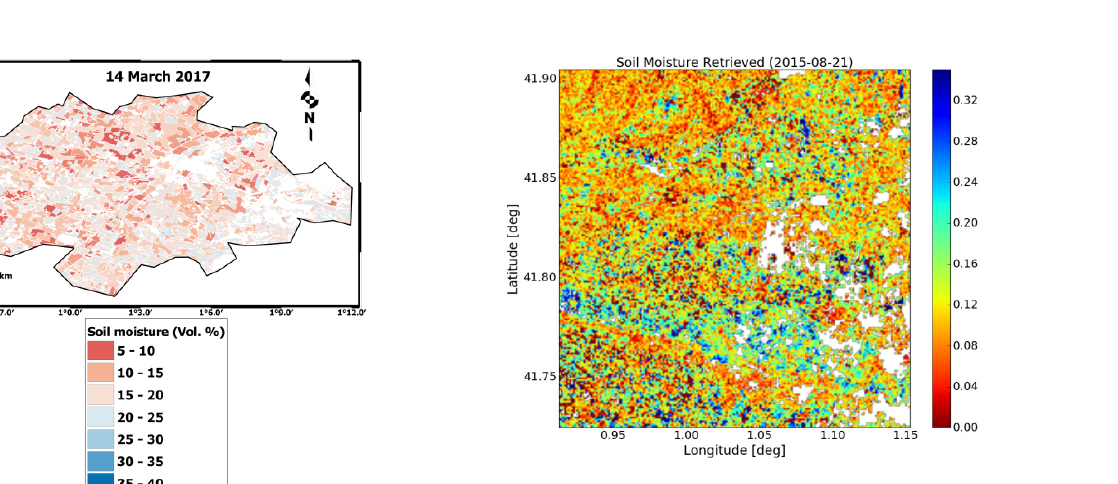
Figure 1. Retrieval of soil moisture over Occitanie region (France)